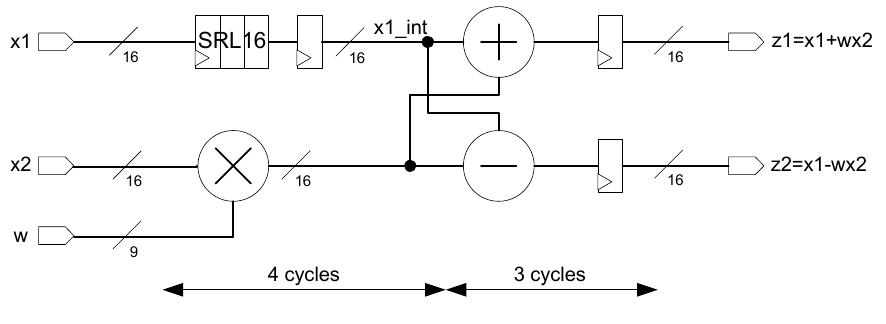
Figure 5. Pipeline radix-2 butterfly in FPGA.